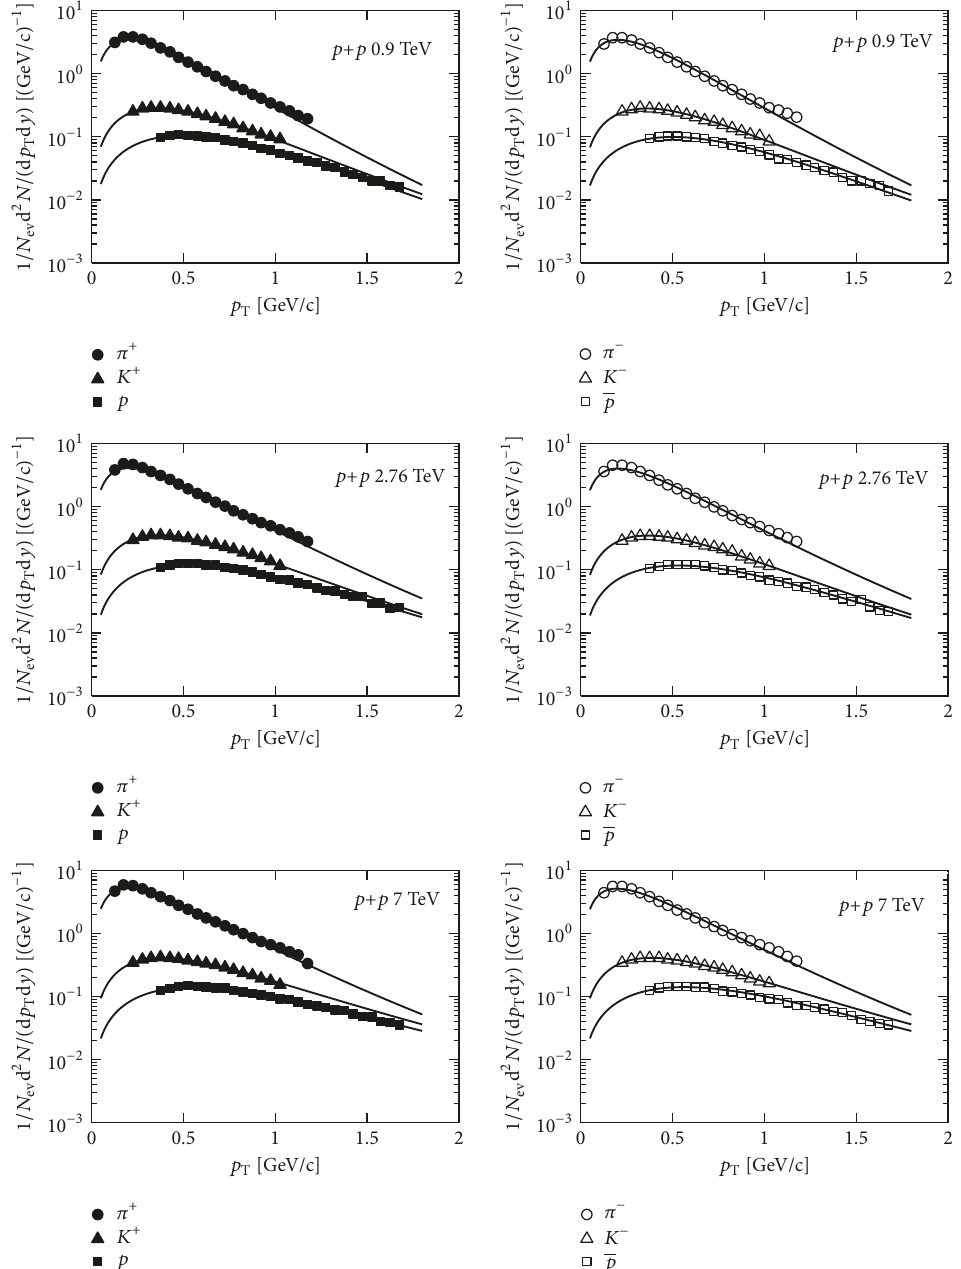
Figure 4: The transverse momentum distributions of the identified charged particles ( |𝑦| < 1) produced in 𝑝 + 𝑝 collisions at √𝑠 = 0.9, 2.76, and 7 TeV (from top to bottom). The solid dots, solid triangles, solid squares, circles, triangles, and squares represent the experimental data of the CMS Collaboration [46]. The solid curves are the results calculated from Equation (19). Table 2: The values of 𝑞 , 𝑄 0 , and 𝜒 2 /NDF obtained from the analyses of PHENIX data [45] in 𝑝 + 𝑝 collisions at √𝑠 = 200 GeV.